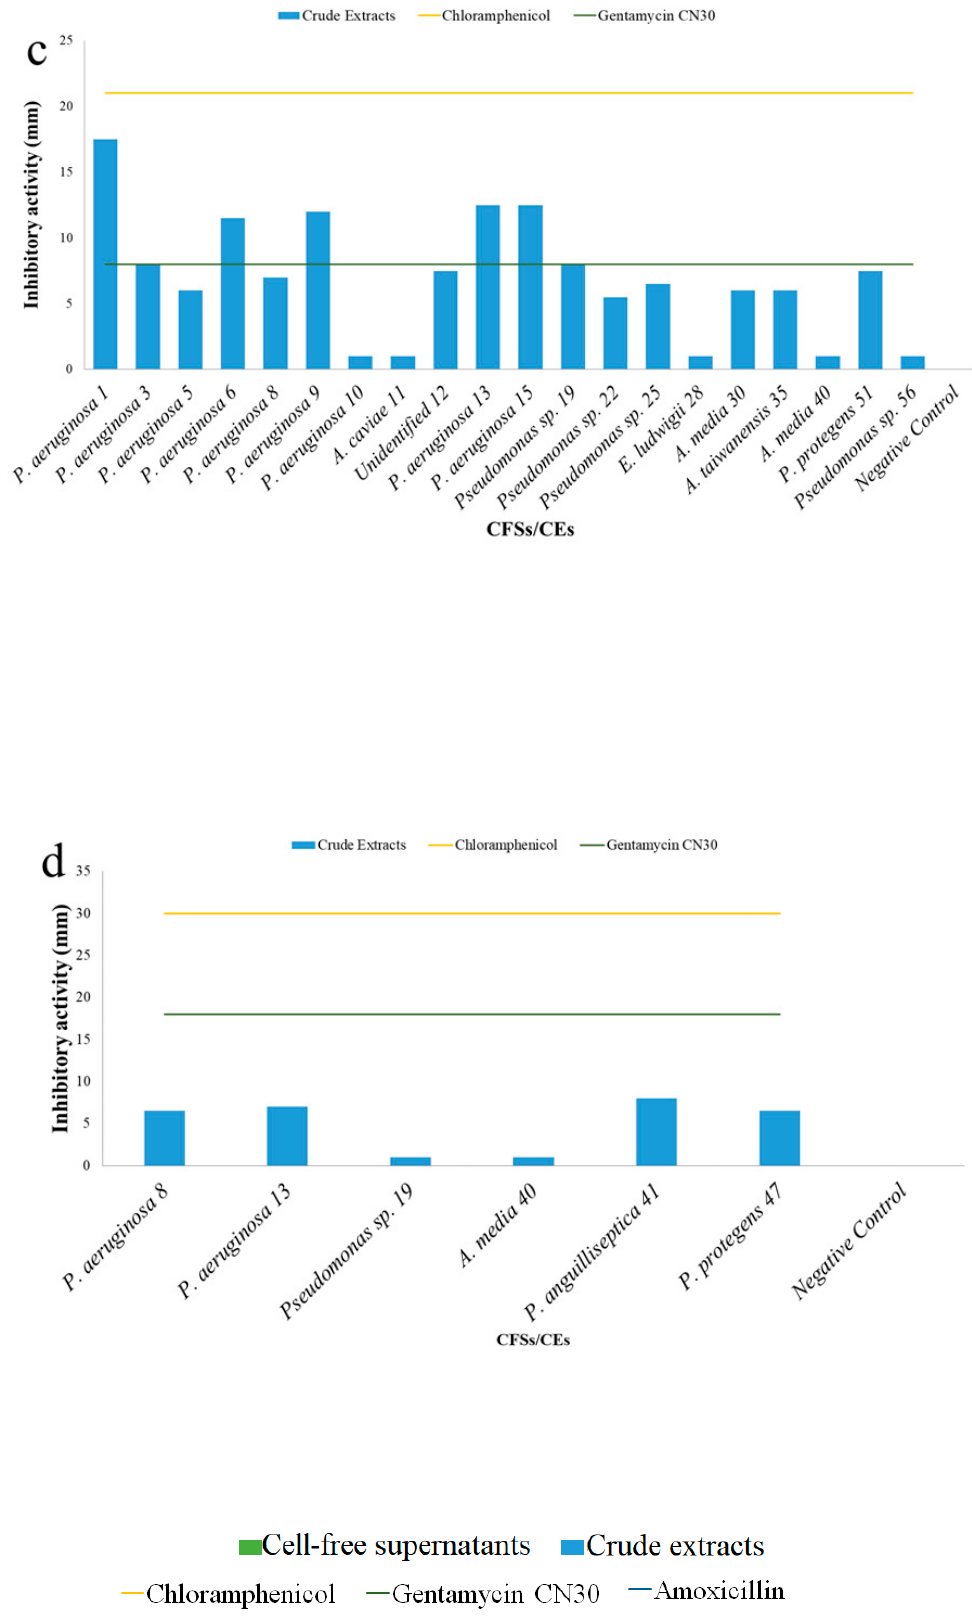
Figure 5. Inhibitory activity exhibited against the target S. aureus H1610 ( a ), P. mirabilis H1643 ( b ), K. pneumoniae H1637 ( c ) and A. hydrophila H1563 ( d ) by concentrated supernatants (CFSs green) and crude extracts (CEs blue) obtained by bacterial isolates.